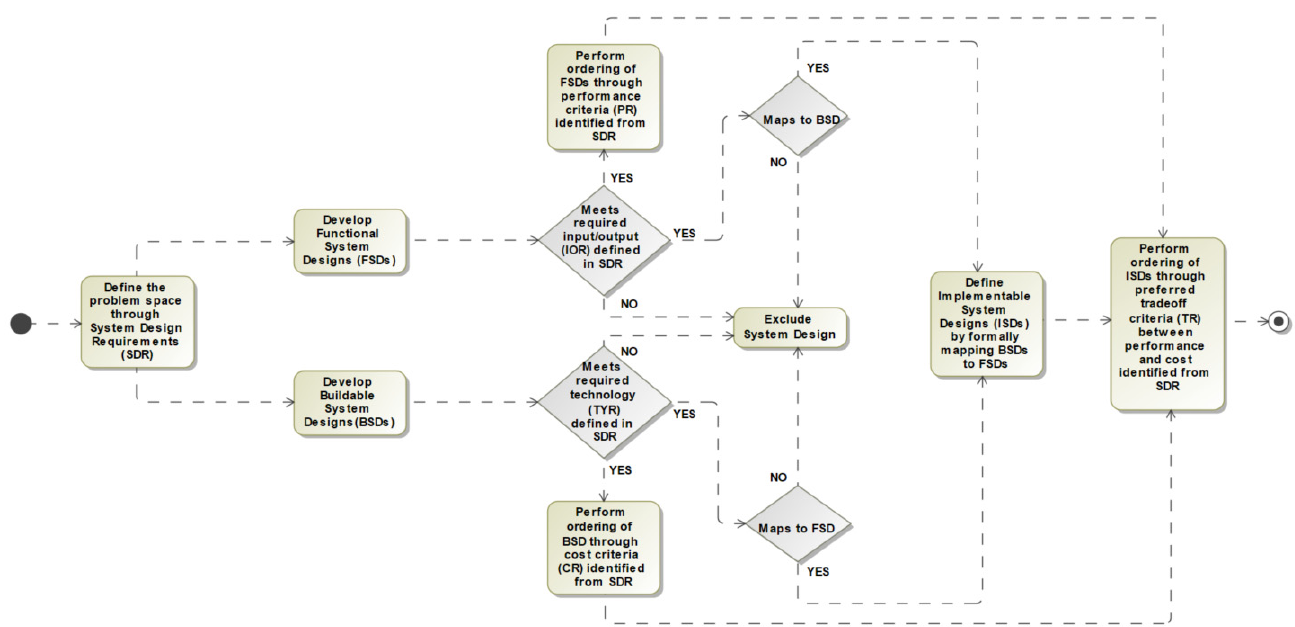
Figure 3. A rendition of the activities involved in Wymore’s T3SD. These activities serve as a basis for the remainder of this article, where further explanation of the activities is provided.